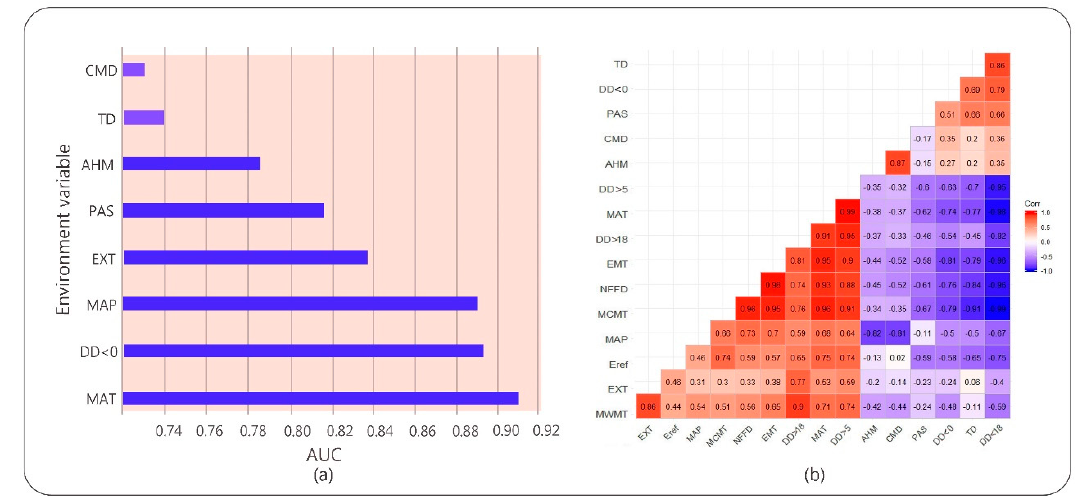
Figure 2. ( a ) Results of jackknife test for the area under the curve (AUC) of individual environmental variable importance relative to eight environmental variables for MaxEnt model. ( b ) Correlation analysis of the independent variables. The red squares are for positive correlations and the blue ones for negative correlations. The stronger the correlation, the darker the color.